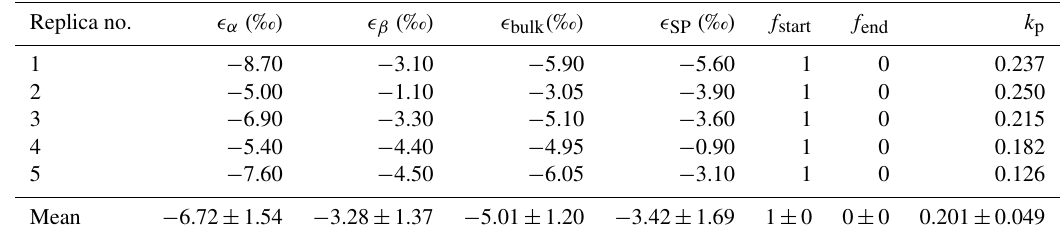
Table 4. Isotopic fractionation, extremes of the unreacted fraction parameter ( f start and f end ), and production rate ( k p ) in ppm(minmL KNO 3 ) − 1 for the production of N 2 O from P. chlororaphis . Replica